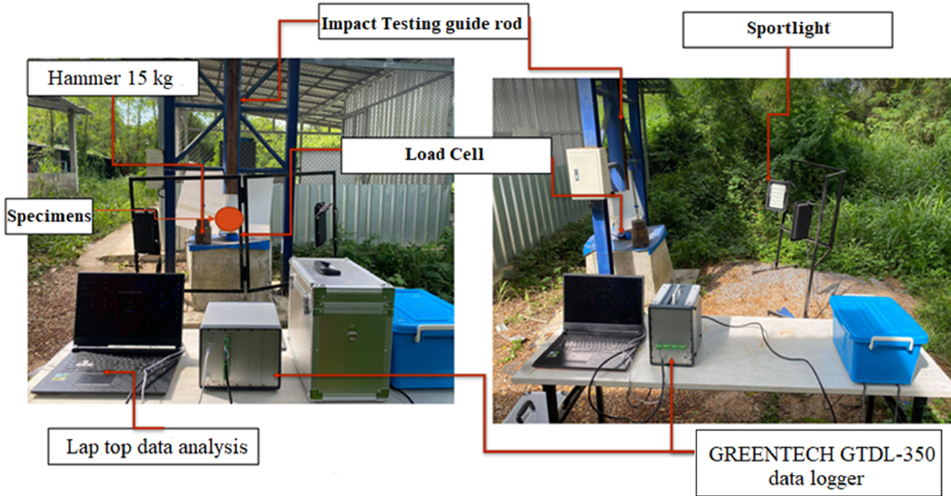
Figure 2: Impact testing machine used in this study *spotlight, laptop